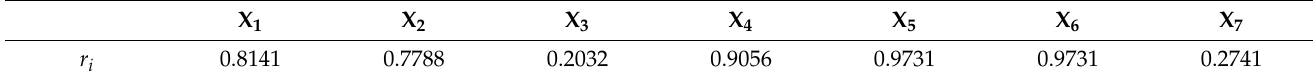
Table 4. Fuzzy membership degrees of influencing